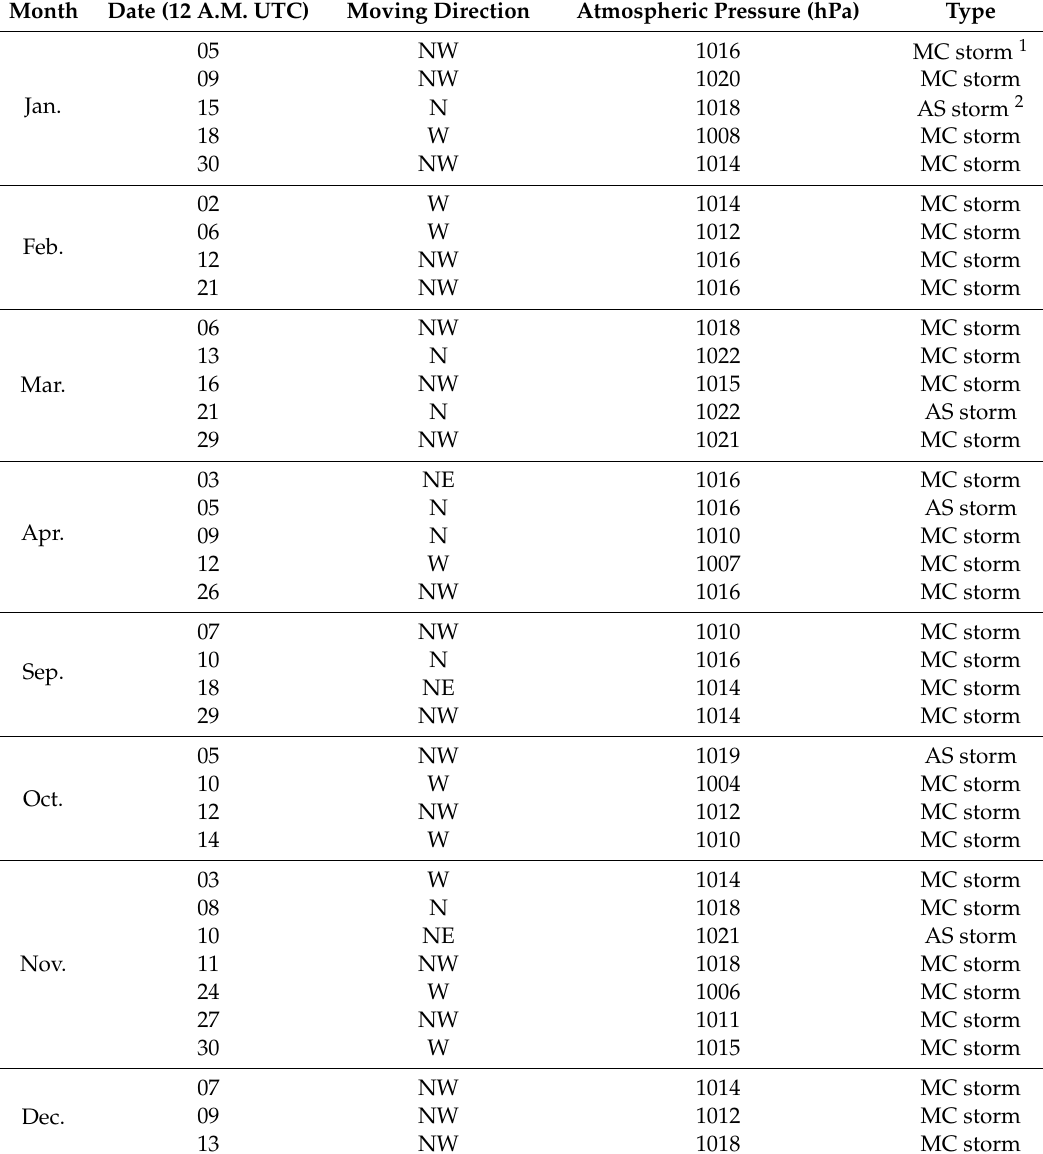
Table 1. Atmospheric cold fronts from the daily weather maps of the National Centers for Environmental Prediction, Weather Prediction Center in 2004, excluding May, June, July and